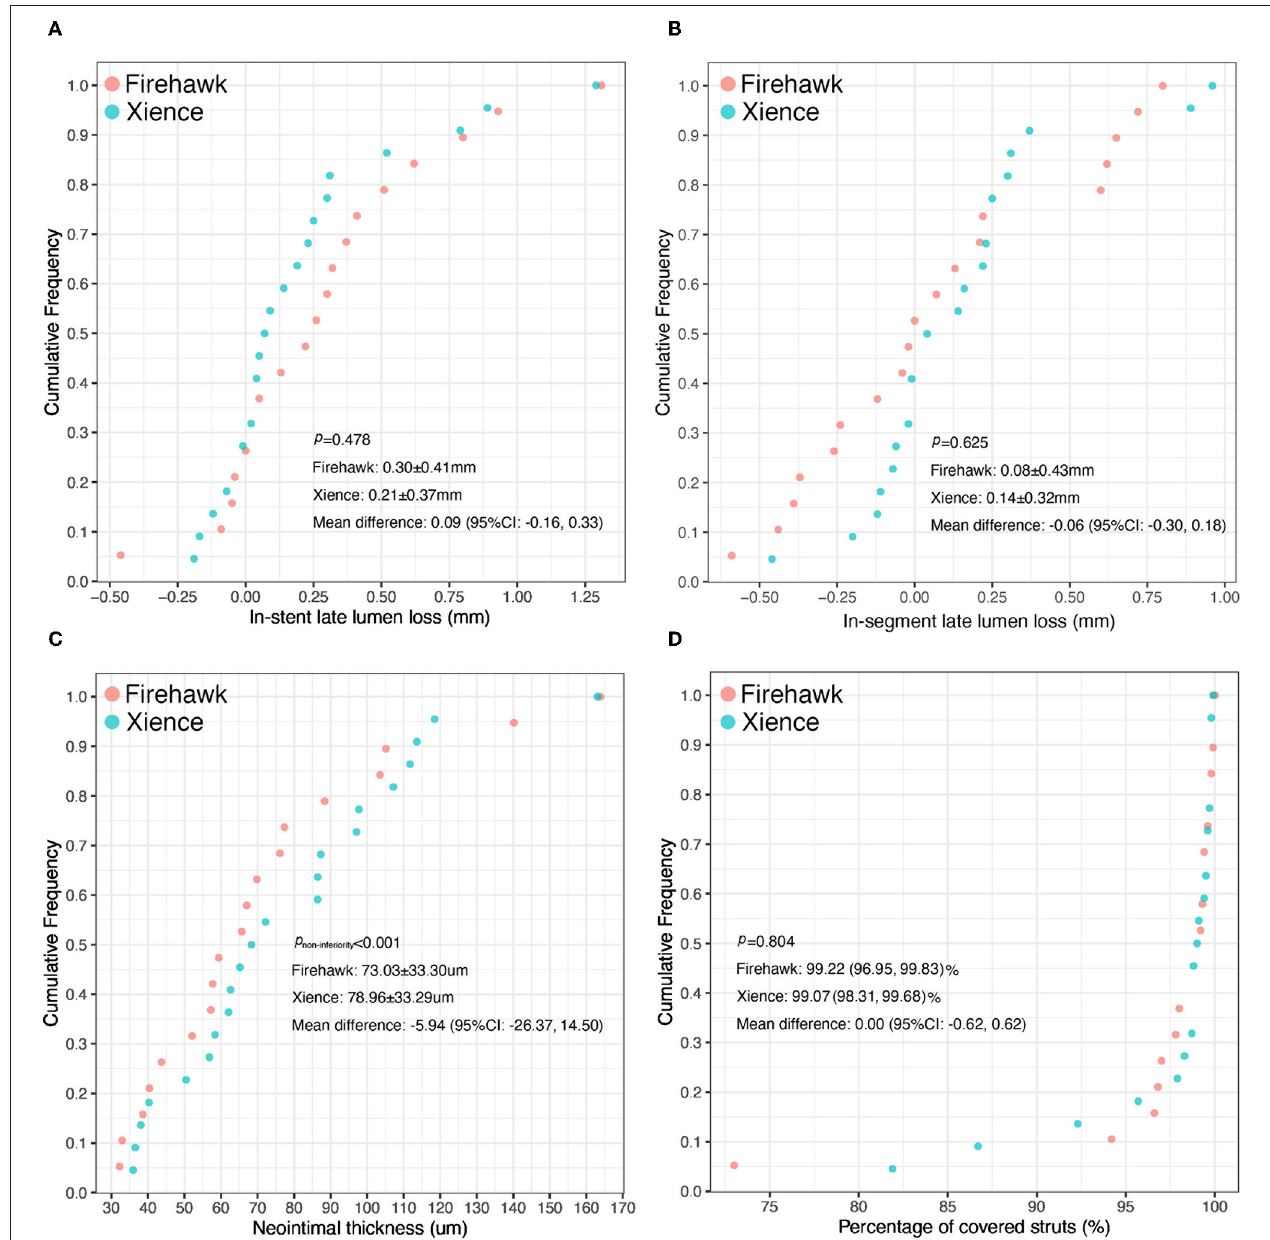
FIGURE 2 | Cumulative frequency distribution curves of in-stent late lumen loss (A) , in-segment late lumen loss (B) , the mean neointimal thickness (C) , and the percentage of covered stent struts (D) at the 6-month OCT and angiographic follow-up.